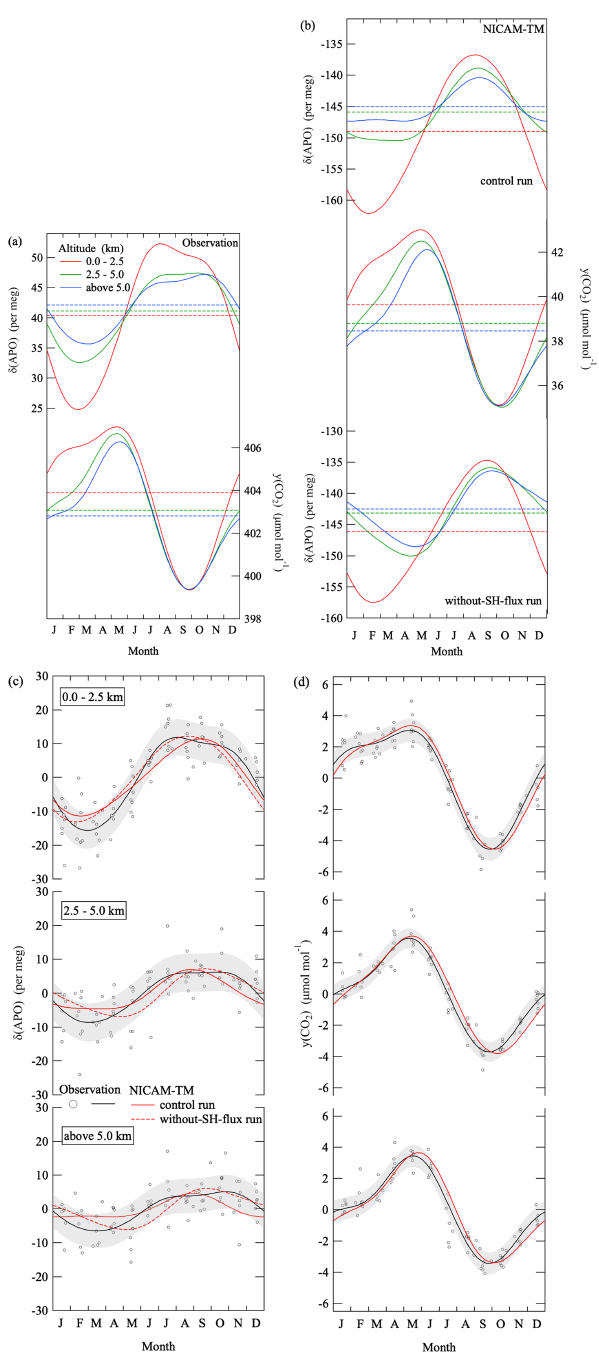
Figure 7. Same as in Fig. 6 but for average seasonal cycles of δ (APO) and the CO 2 amount fraction in the troposphere over MNM.